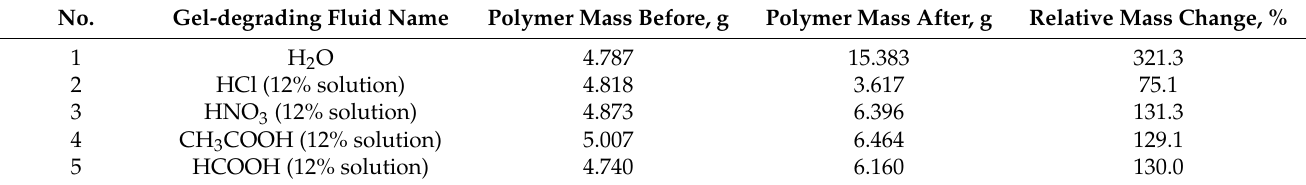
Table 6. Results of the selection of a destructing agent for the polymer composition with a gel-time